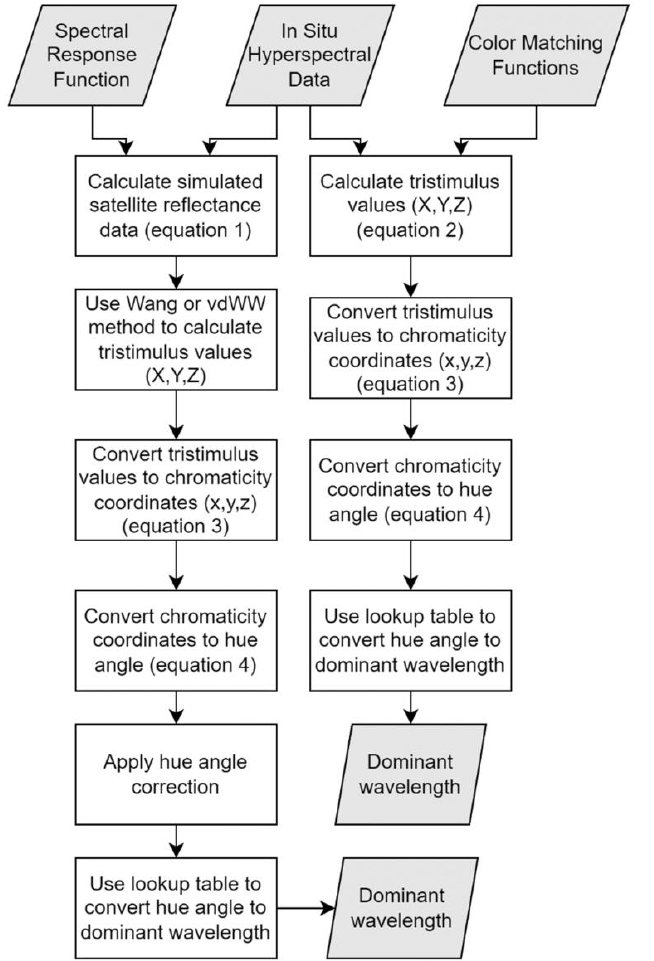
Figure 2. Flowchart of the calculation steps used to convert the hyperspectral data to the dominant wavelength, λ d